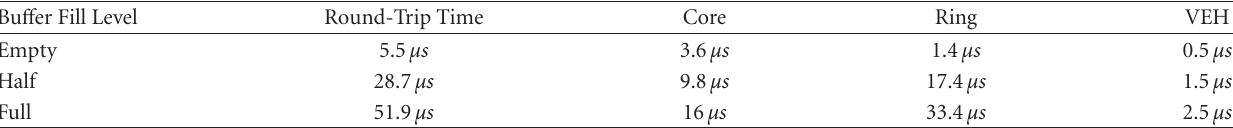
Table 4: Round-Trip Time for a 1000 B packet: overall and per system